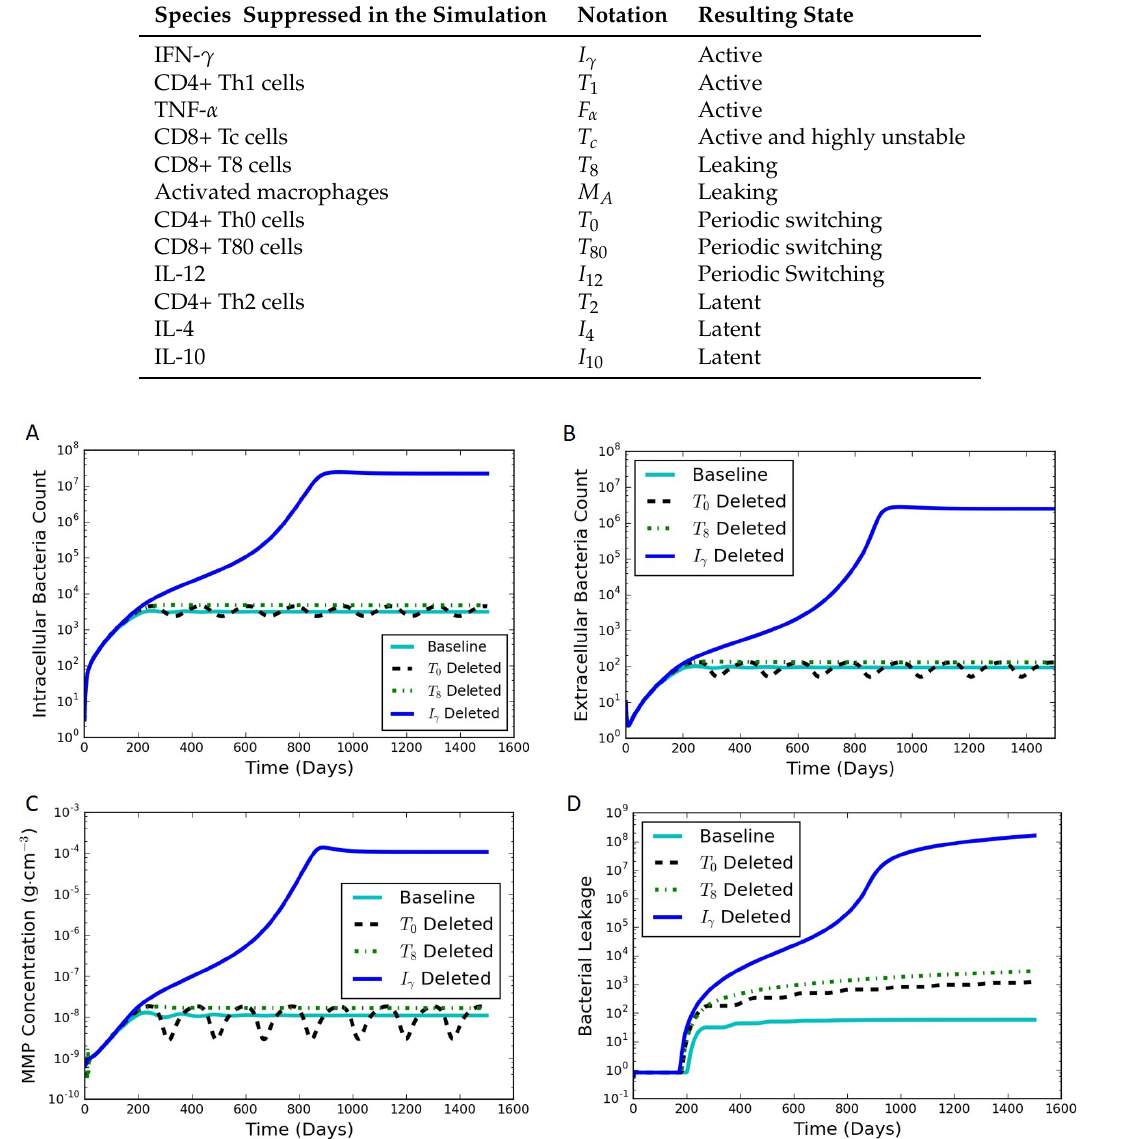
Table 3. Summary of in silico immune system pertubation results.